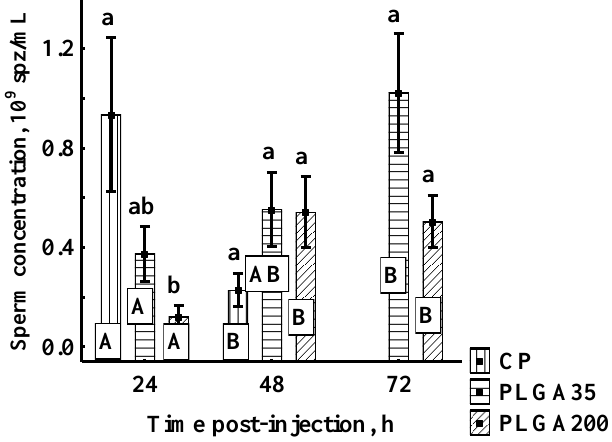
Figure 5. Spermatozoon concentration after hormone treatment. Significant differences among groups at a sampling point are indicated by lowercase letters ( p < 0.05). Significant differences within an experimental group are indicated by uppercase letters ( p < 0.05). Experimental treatments: CP — carp pituitary extract, dose 4 mg/kg; PLGA35 — Alarelin, dose 35 µg/kg; PLGA200 — Alarelin, dose 200 µg/kg.